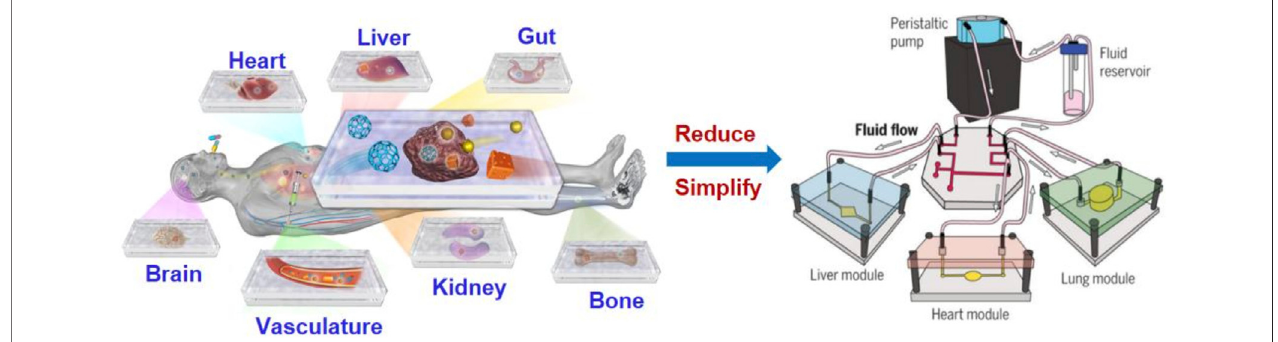
FIGURE 1 | Illustration of organ-on-a-chip technologies to mimic human organs structure and function (Park et al.,